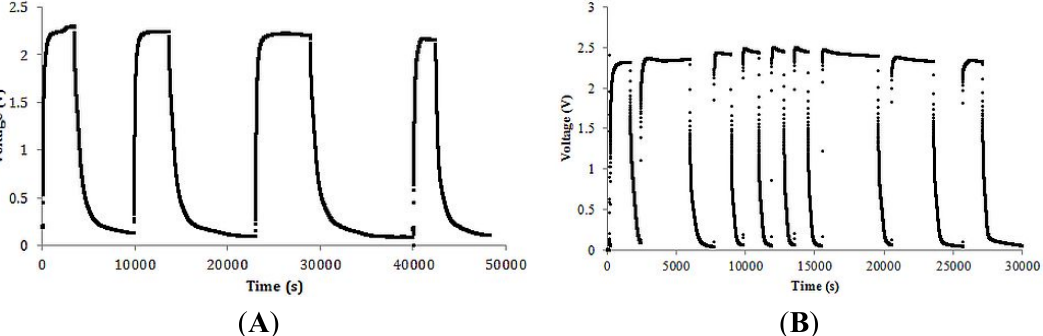
Figure 1. Multiple cycles. ( A ) Four full cycles of charge/discharge on the 10.6 μ m, 0.925 g·mL − 1 capacitor, 20 k Ω load (Table 1). Clearly, the maximum charging voltage